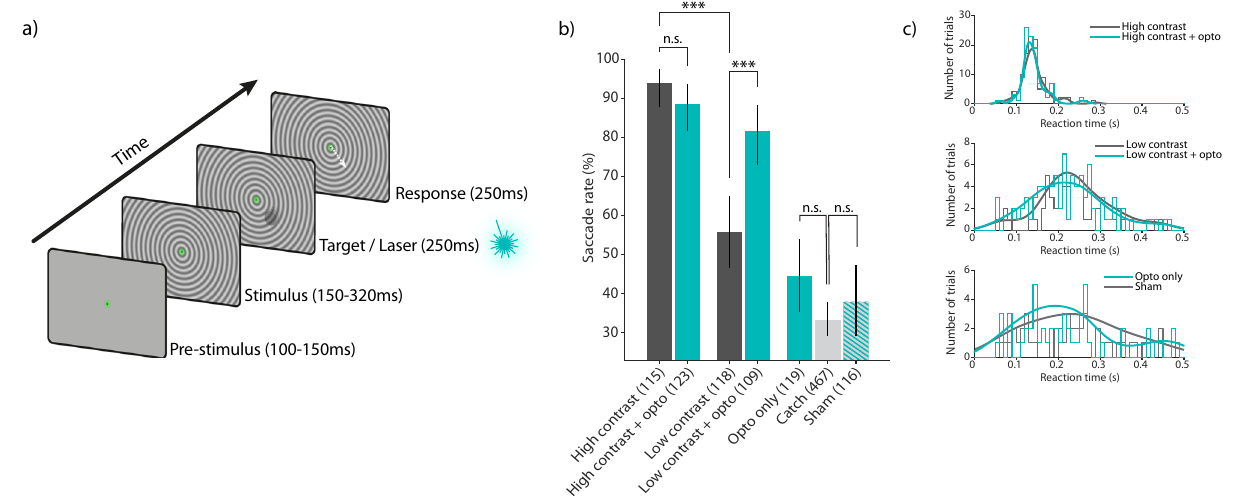
Fig. 8 | Visual and optogenetic detection task and behavioral results. a Schematic illustration of the detection task. After a brief pre-stimulus fi xation period, a background stimulus was shown, followed by the onset of a small visual targetwith eitherhigh orlow contrast.On 50% of these trials, the visualtarget was paired with optogenetic stimulation. Additionally, trials without visual target were included, either with effective laser stimulation ( “ Opto only ” condition) or with control laser stimulation, in which the optic fi ber was placed outside the cra- niotomy ( “ Sham ” condition), or with no laser stimulation ( “ Catch ” ). All trial con- ditions except catch trials had identical timing and were rewarded if the monkey executed a saccade 50 – 500ms after target or laser onset. b Saccade rates for all task conditions. The animal showed increased detection performance (higher saccade rate) for high-contrast visual targets compared to low-contrast targets (93.9% vs. 55.9%, n =115 and n =118 trials, respectively; two-sided Chi-squared test; P =3.64e-10). Pairing high-contrast visual targets with optogenetic stimulation did notresultinadifferenceinsaccaderate( n =115and n =123trials,respectively;two- sided Chi-squared test; P =0.283). Saccade rate increased signi fi cantly when low-